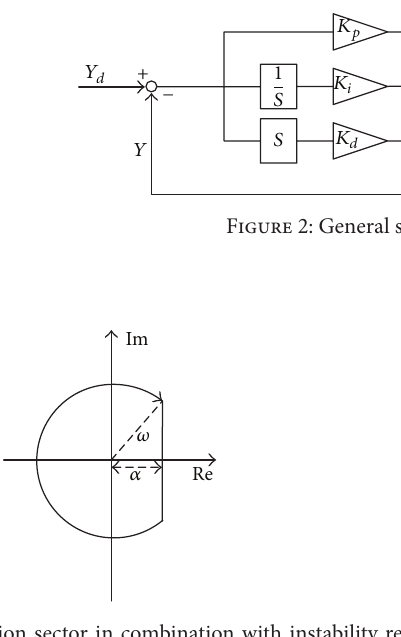
Figure 3: Construction sector in combination with instability re-